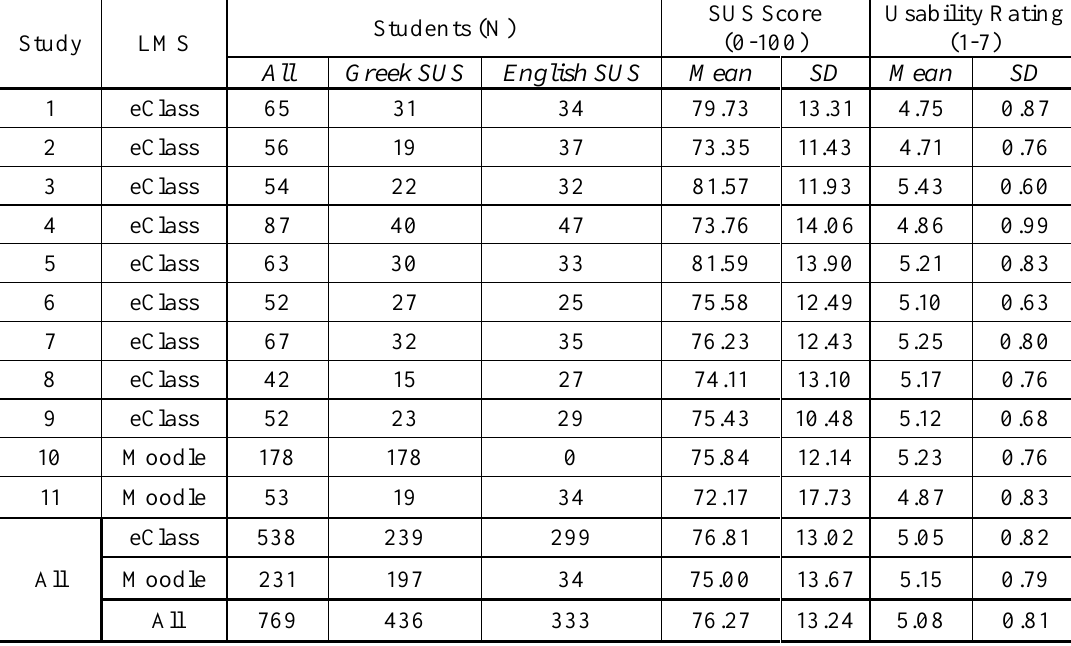
Sample Size and Descriptive Statistics (SUS score, Usability Rating) in our